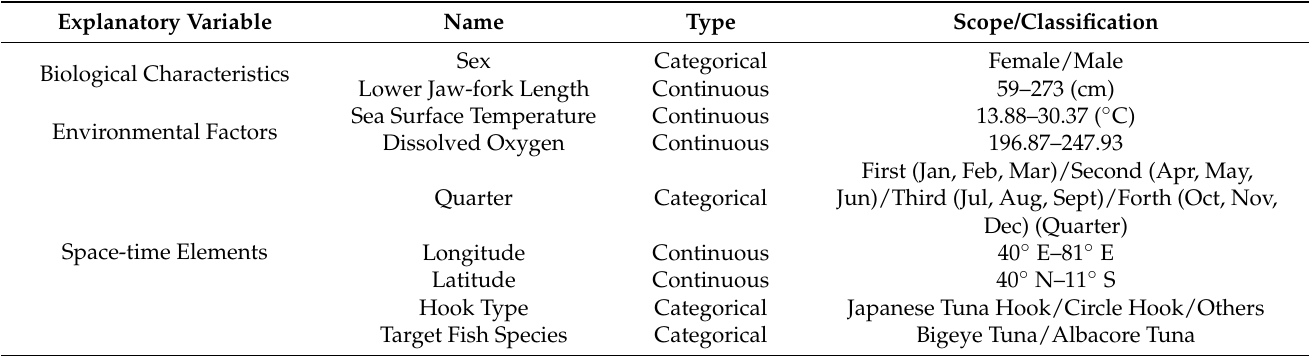
Table 1. The scope of each continuous explanatory variable and the classification of each categorical explanatory variable were evaluated for importance in the at-haulback mortality of Xiphias gladius